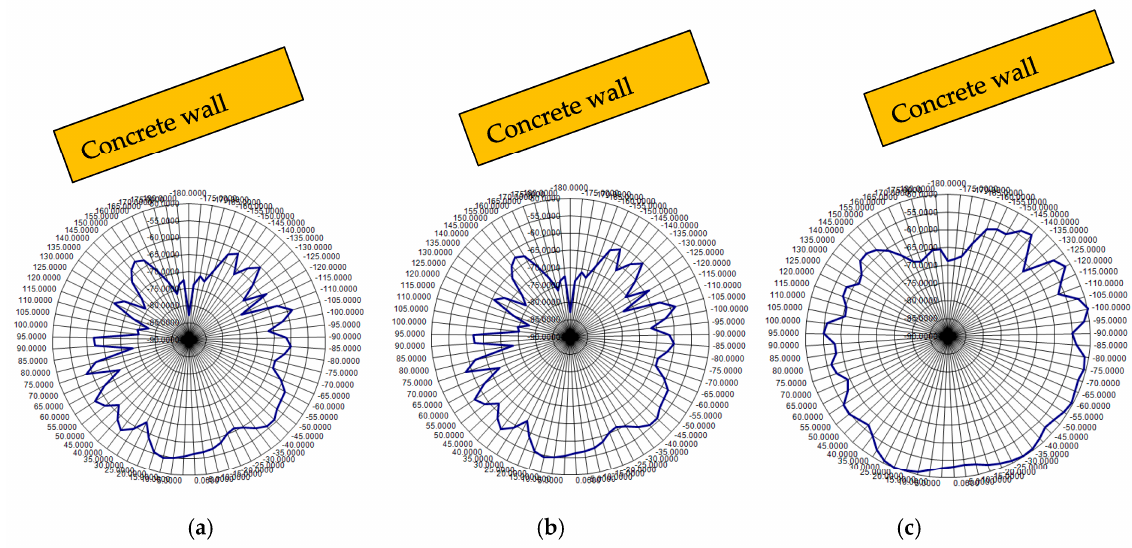
Figure 3. RF radiation at ( a ) 2.40 GHz frequency, ( b ) 2.45 GHz frequency, and ( c ) 2.48 GHz frequency.